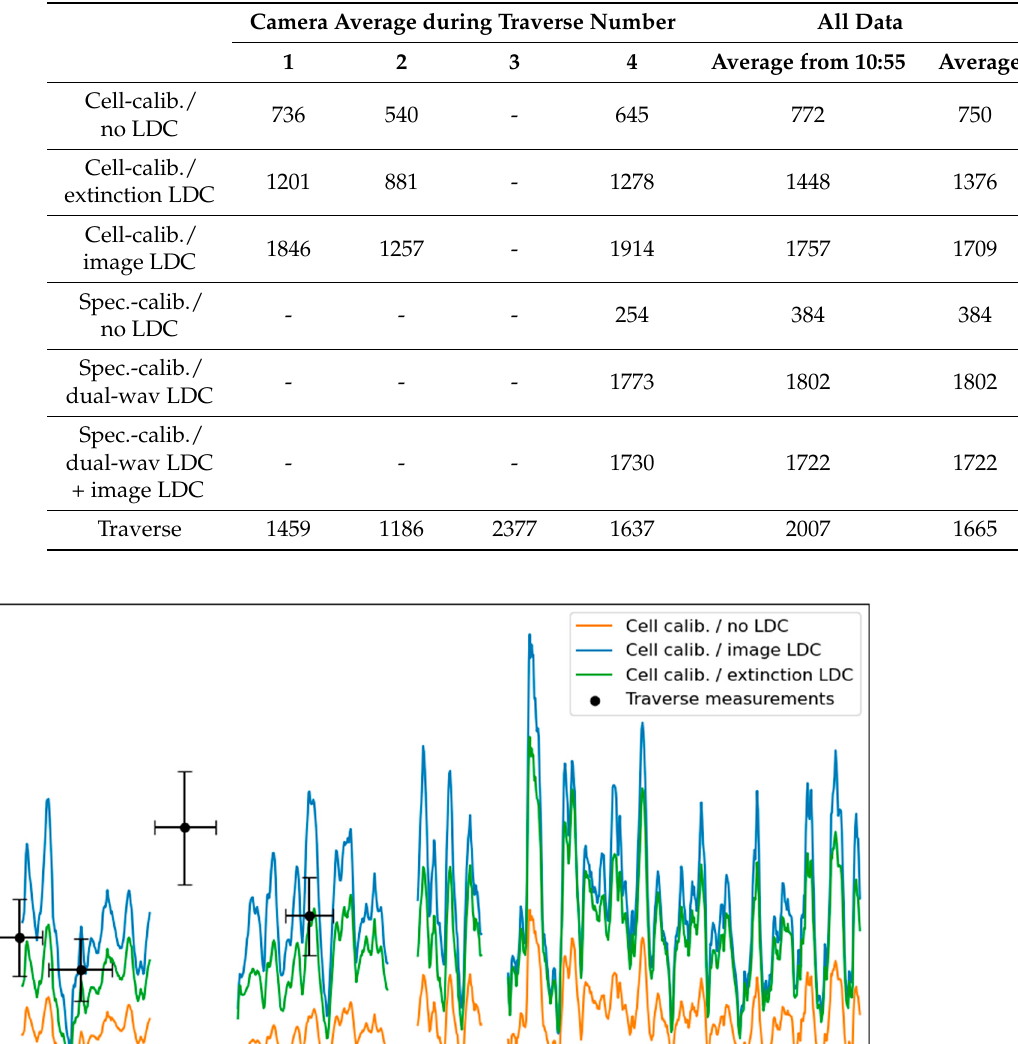
Table 3. Average SO 2 emission rates (in metric tons/day) as measured by camera methodologies, with different light dilution corrections (LDC) and traverses for 15 January 2018 for each traverse time interval. An overall average for all measurements from the day is also included.